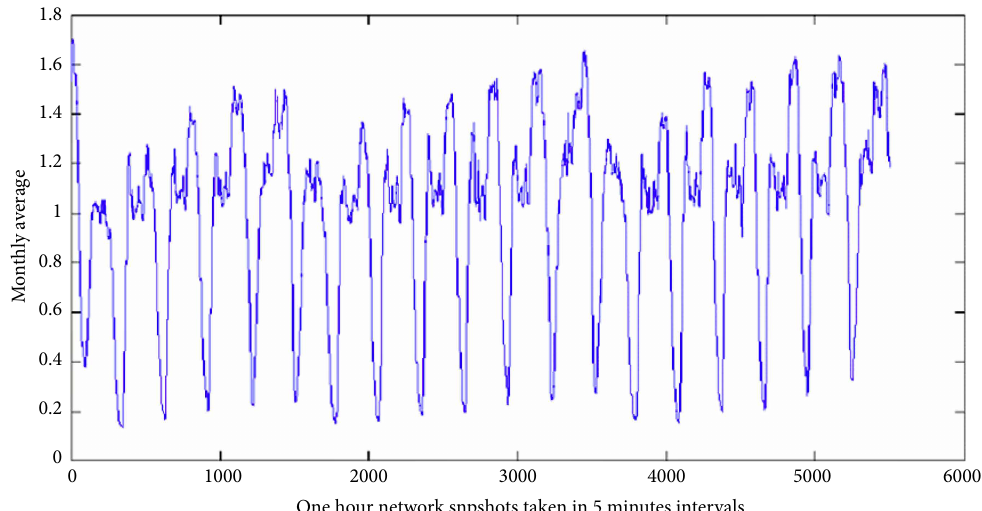
Figure 11: Dynamics of the mean degree of the rides network nodes. X -axis denotes the time, given in 5 minutes granularity. Y -axis denotes the change of the mean degree of the network compared to its monthly average.